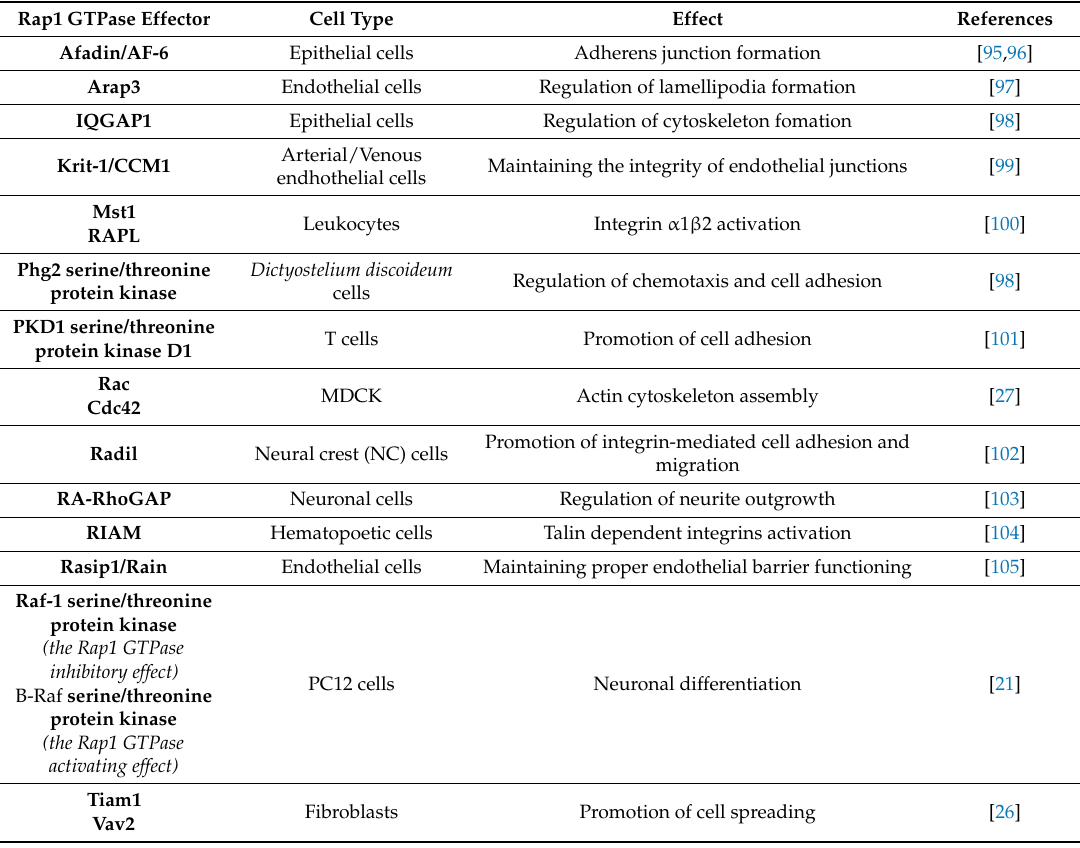
Table 1. The Rap1 effectors and consequences of their activation,